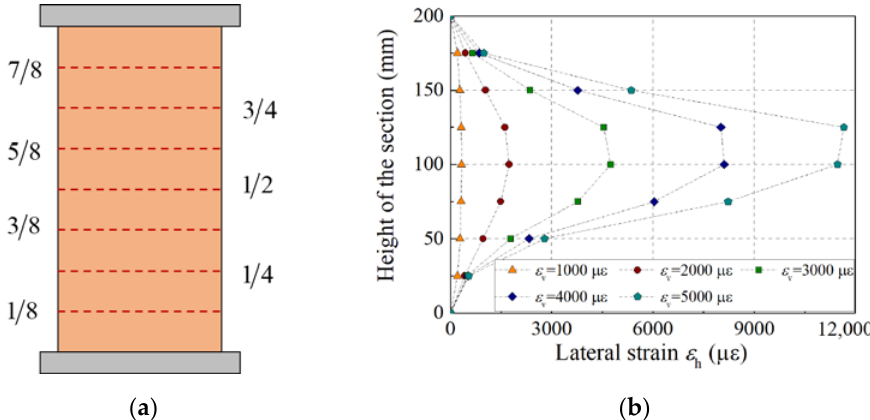
Figure 7. Distribution of the lateral strain along the specimen height: ( a ) location of the measured section; ( b ) distribution of the lateral strain.